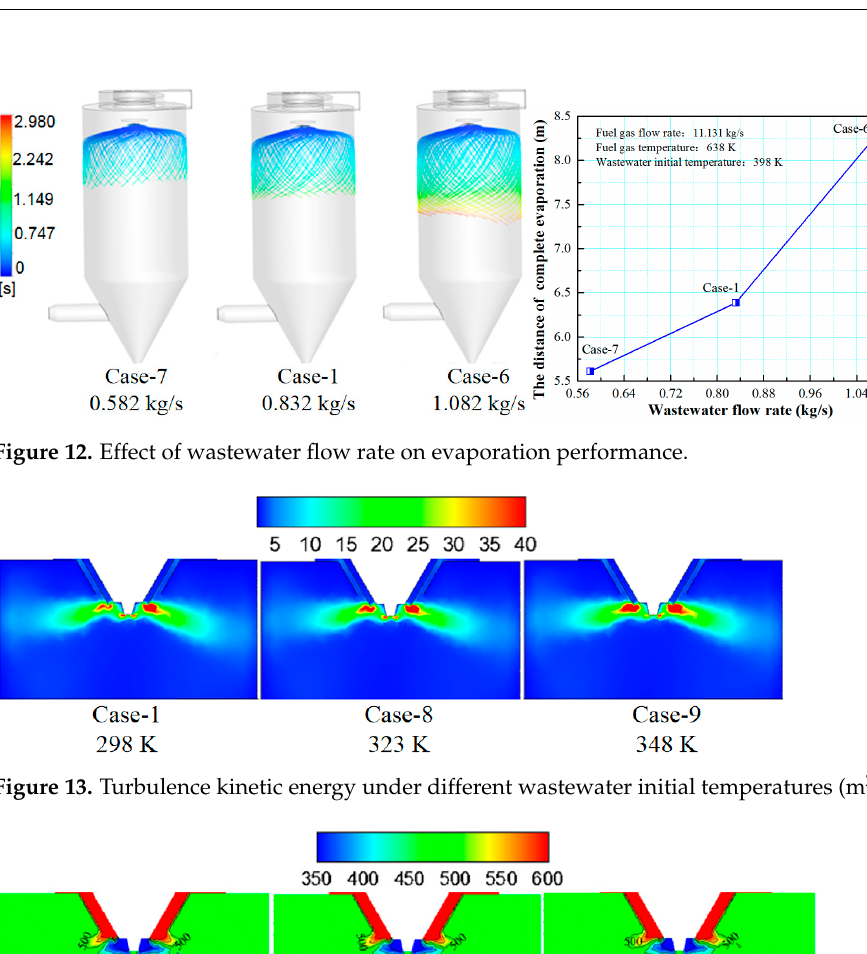
Figure 13. Turbulence kinetic energy under different wastewater initial temperatures (m 2 /s 2 ). Figure 14. Temperature under different wastewater initial temperatures (K). Figure 14. Temperature under different wastewater initial temperatures (K). Figure 14. Temperature under different wastewater initial temperatures